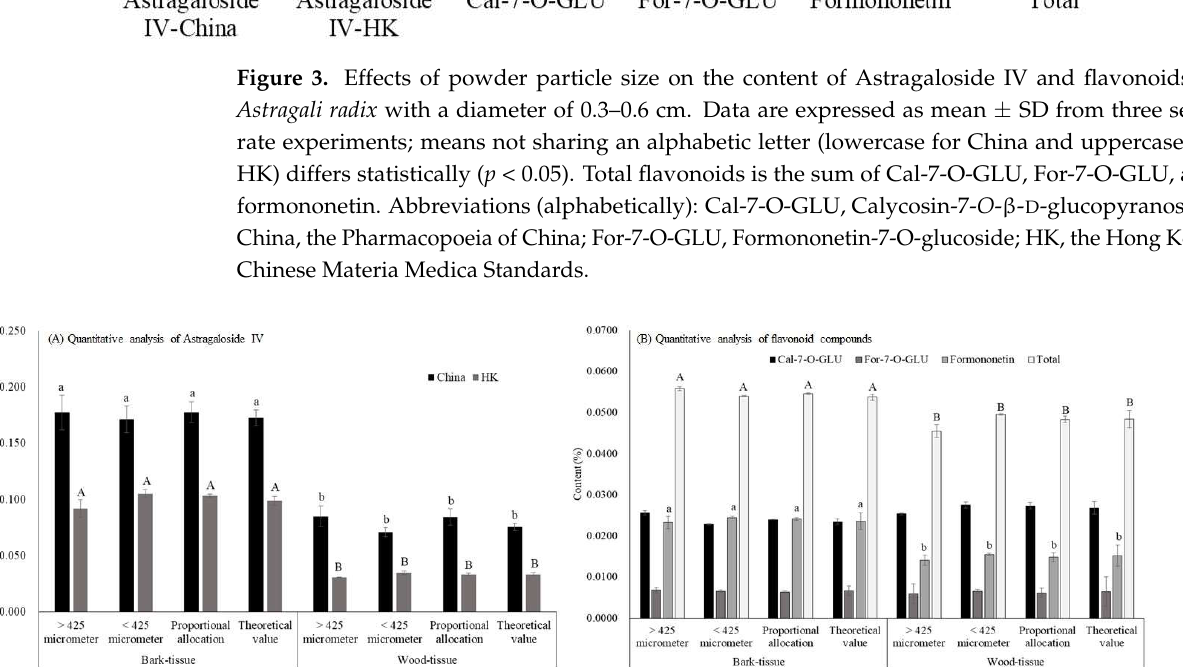
Figure 5. Correlation analysis between the active component content (Astragaloside IV and flavo- noids) and the ratio of surface area in bark- and wood-tissue surface area in Astragali radix with different diameters. The surface area of bark and wood-tissue was calculated by Image J software and the surface area of bark was computed by subtracting wood-tissue from the total area. The ratio of surface area in bark and wood-tissue was calculated as bark area divided by wood-tissue area. Total flavonoids is the sum of Cal-7-O-GLU, For-7-O-GLU, and formononetin. Abbreviations (al- phabetically): Cal-7-O-GLU, Calycosin-7- O -β- D -glucopyranoside; China, the Pharmacopoeia of China; For-7-O-GLU, Formononetin-7-O-glucoside; HK, the Hong Kong Chinese Materia Medica Standards.